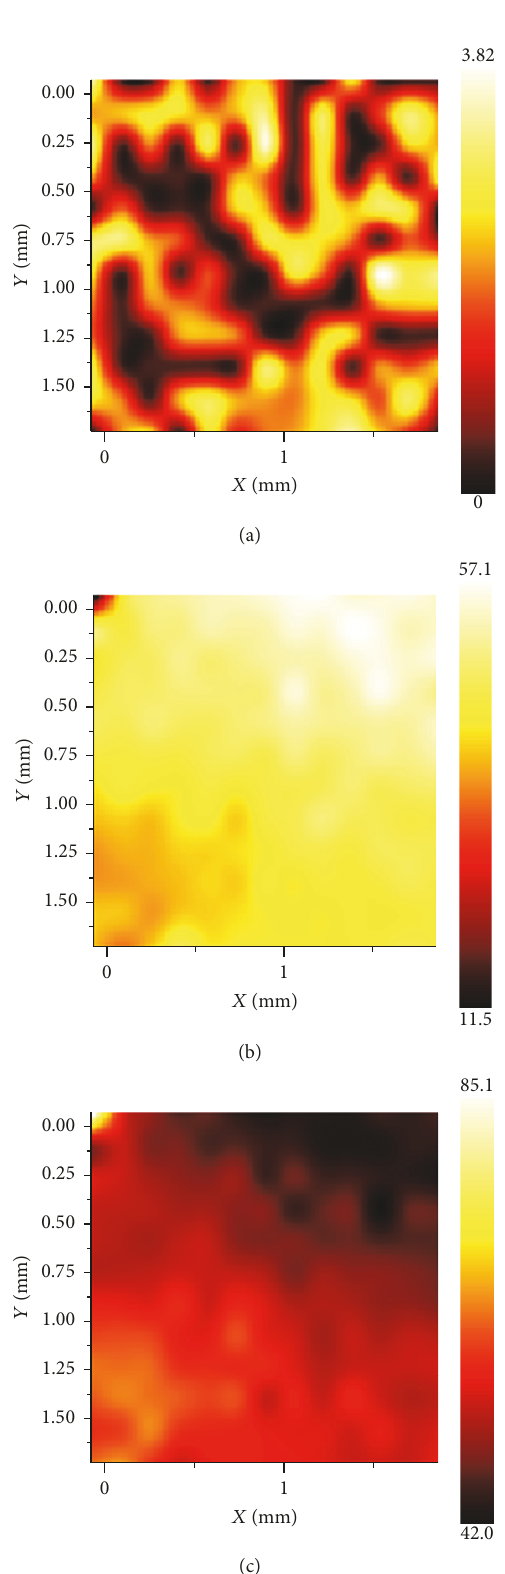
Figure 17: XPS maps for the atomic percentages of (a) Al2p; (b) O1s; and (c) Mg1s for the AZ91D alloy immersed for 15h in 3.5 wt.% NaCl solution at room